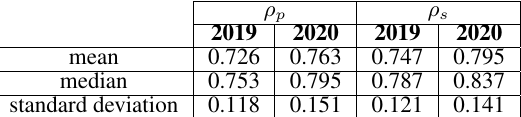
Table 1. Summary statistics for Pearson’s correlation coefficients ( ρ p ) and Spearman’s rank correlation coefficients